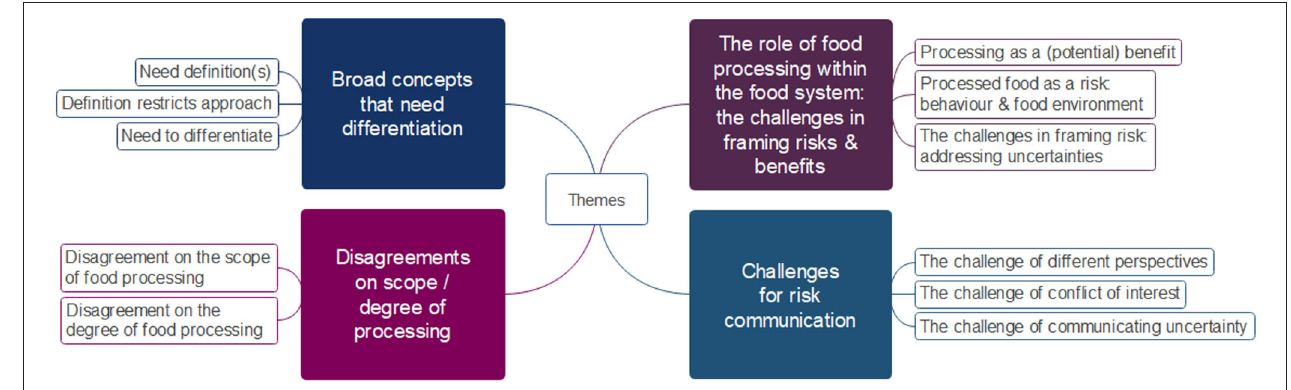
FIGURE 1 | Themes generated from group discussions about the conceptualisation of processed food, agreements and disagreements among professionals, and the challenges in communicating to the